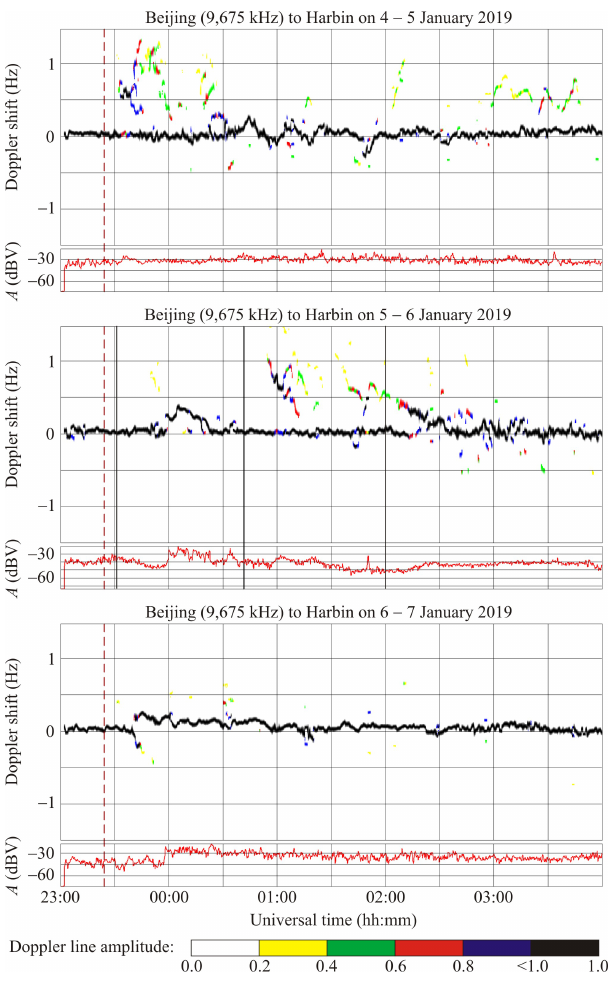
Figure 10. The same as in Fig. 4 but for the Beijing to Harbin radio- wave propagation